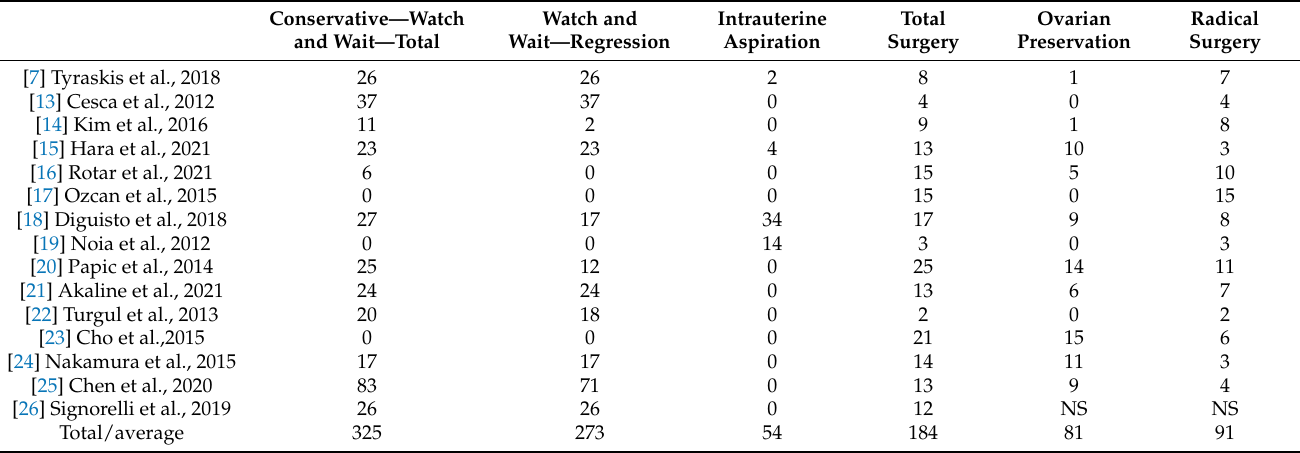
Table 2. Treatment applied for fetal ovarian